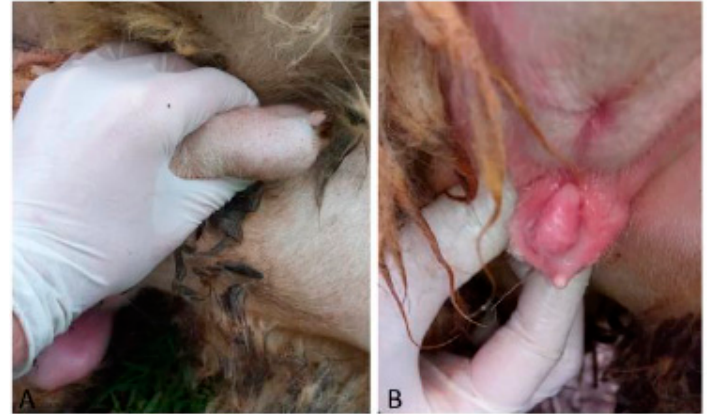
Figure 4. Case 4. ( A ) Isolation of the testis-like structure in the mammary region; ( B ) particular of the enlarged clitoris.